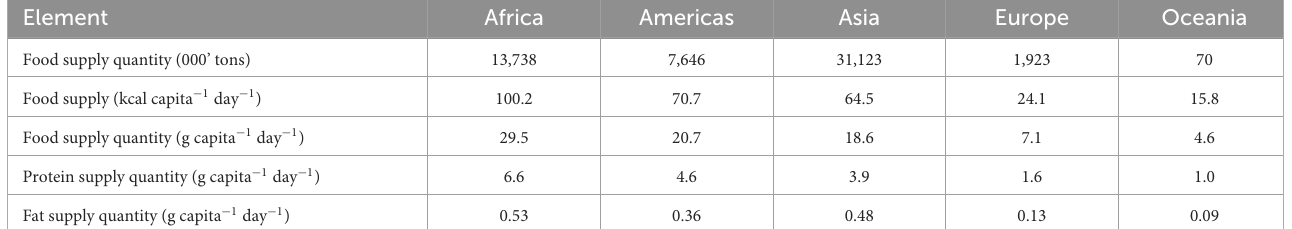
TABLE 2 Food supply through pulses in different regions of the globe, 2019 (FAOSTAT, 2022). Element Africa Americas Asia